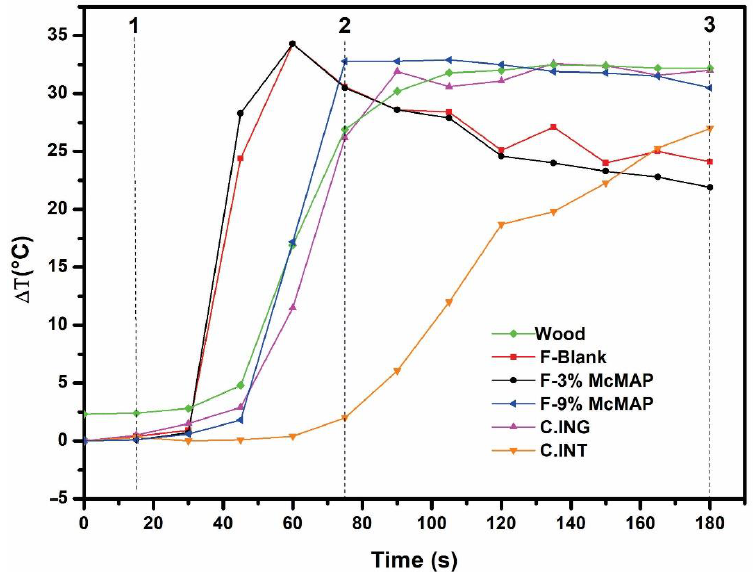
Figure 7. Fire behavior of the formulated coatings.